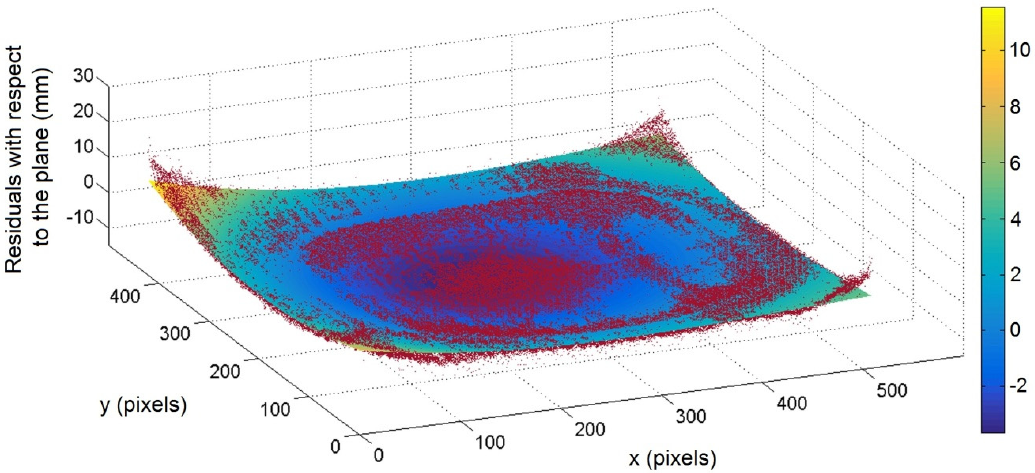
Figure 8. Point cloud of residuals (mm) in red, at 0.8 m, together with the surface (color-coded) fitting the